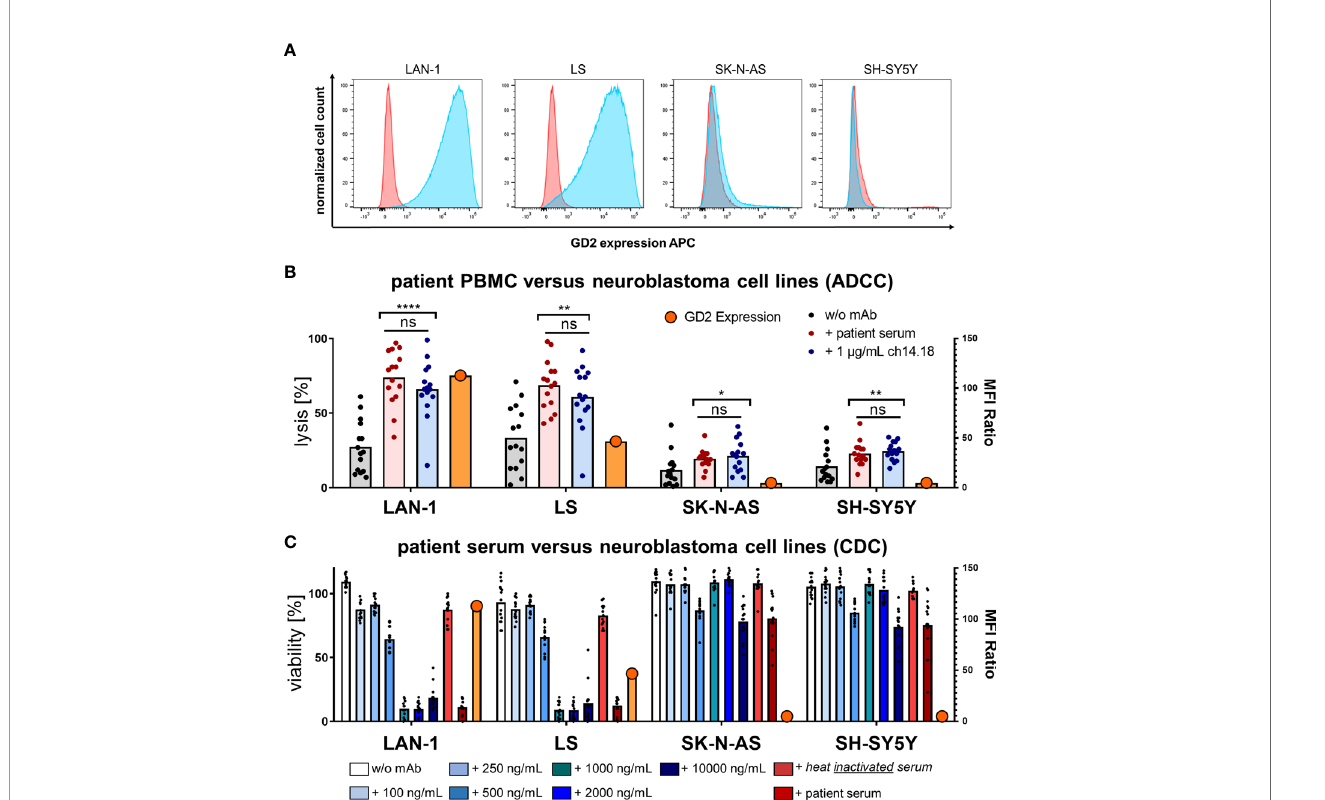
FIGURE 5 | GD2 expression and cytolysis of neuroblastoma cell lines via ADCC and CDC by PBMCs and serum of patients. (A) GD2 expression of the neuroblastoma cell lines LAN-1, LS, SK-N-AS, and SH-SY5Y was measured by fl ow cytometry using primary labeled GD2 PE (clone 14G2a) mAb and a mouse IgG2a, k PE mAb as isotype control. The median fl uorescence intensity (MFI) was used to calculate the MFI ratio (MFIR) by the MFI GD2 PE mAb divided by MFI isotype control IgG2a, k PE mAb. Representative univariate histograms are shown. From left to right panels the relative GD2 expression declines MFIR LAN-1 = 112.9 > MFIR LS = 46.8 > MFIR SK-N-AS = 1.3 > MFIR SH-SY5Y = 1. (B) Patient PBMCs acquired post haploidentical HSCT were used to test the direct cellular cytotoxicity and ADCC at an effector to target ratio E:T 5:1 of PBMCs versus the indicated neuroblastoma cell line in a 24 h luciferase-based kill assay. Speci fi c lysis was assessed in the conditions I) PBMCs without mAb versus tumor, II) PBMCs plus patient serum versus tumor, III) PBMCs plus 1 µg/ml ch14.18/CHO mAb versus tumor. (C) CDCwas tested ina coincubation of human serum fromhealthyvolunteer donors(HVDs) at different levelsof concentrationsofadded ch14.18/CHO mAb or heat-inactivated serum ofpatients orserum of patients versus the indicated neuroblastoma celllines ina 24 h luciferase-based killassay without adding anyeffector cells. Data shownin (B) represent mean of triplicates of(n = 15)independent experiments; data shownin (C) represent (n= 3)independent experiments of(n = 15)different donors in (B, C) , respectively.Statistical signi fi cance was determined byone-way ANOVA andTukey post-hoc test. P-values below 0.05 were de fi nedsigni fi cant. ADCC, antibody- dependent cellular cytotoxicity; CDC, complement-dependent cytotoxicity; HVD, healthy volunteer donor.* = <0.05, ** = <0.01, **** = <0.0001. ns, not signi fi